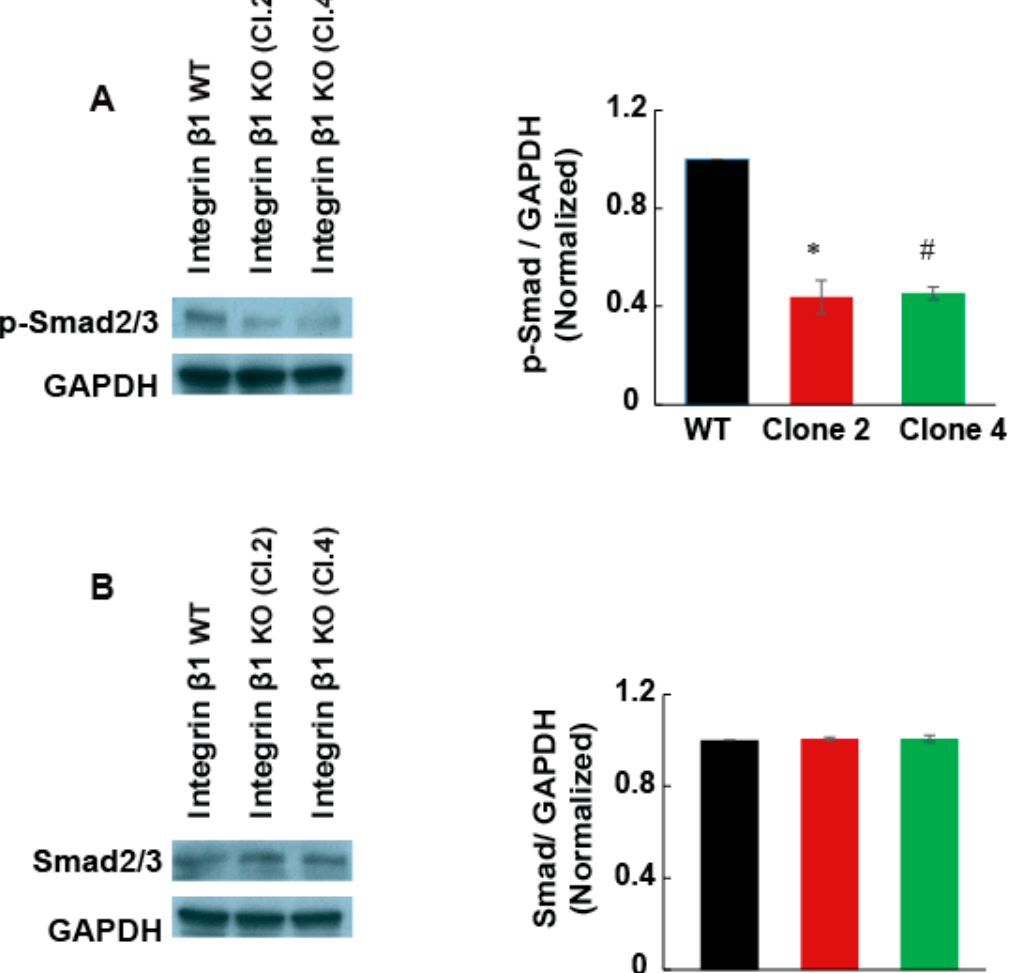
Figure 7. Integrin β 1 deletion downregulated Smad2/3 phosphorylation. ( A ) Cell lysate from integrin β 1 expressing